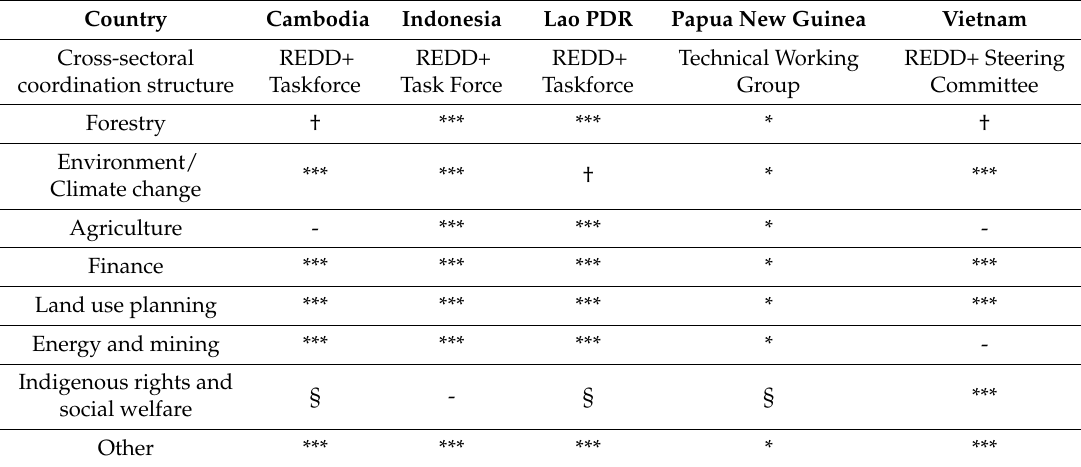
Table 2. Cross-sectoral dimension in key REDD+ management bodies in the five countries in